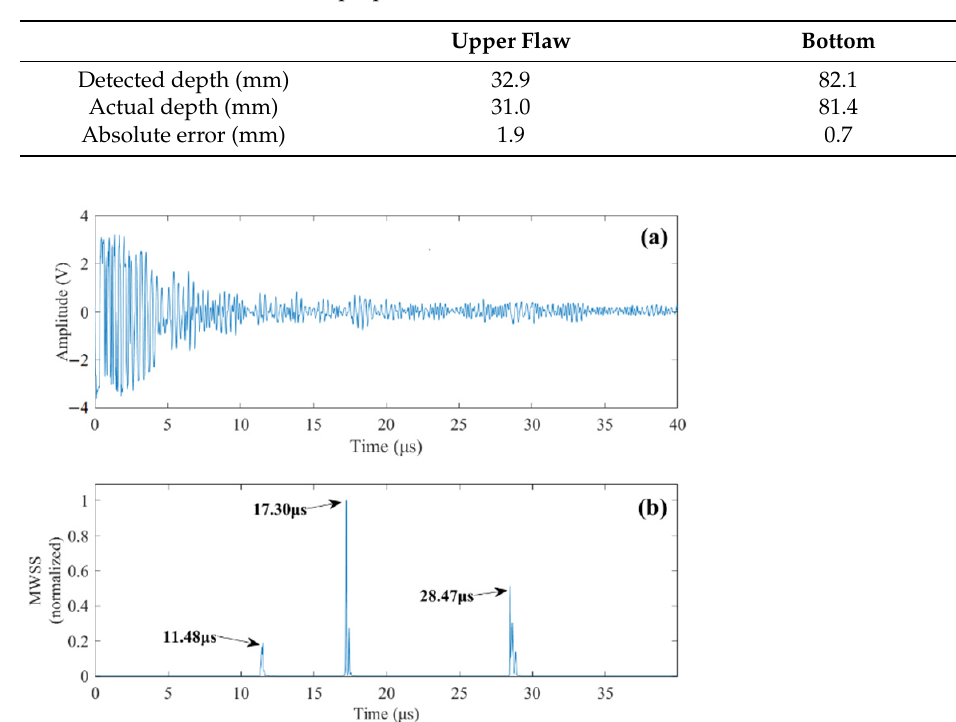
Table 3. Detection results of the proposed method for case 2. Upper Flaw